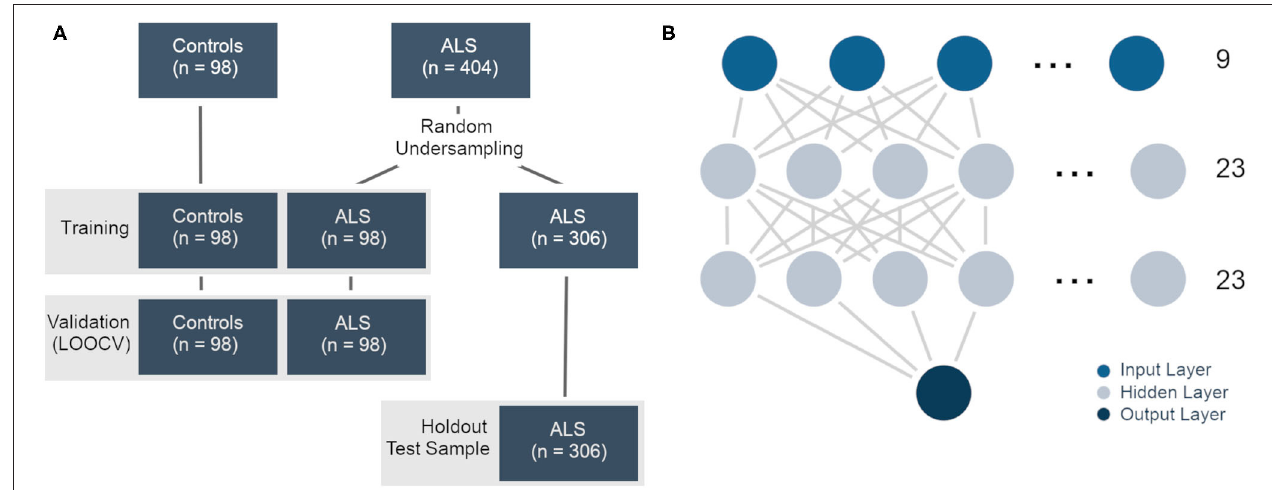
FIGURE 1 | (A) Training, validation, and test samples in the multilayer perceptron classifier. The ALS data were undersampled for the training and validation samples. The leftover data were used as a holdout test sample. (B) Graphical representation of the multilayer perceptron/neural network. There were nine features in the input layer and two classes in the output layer (ALS, controls). The 23 nodes in the two hidden layers were determined by an extensive grid search.